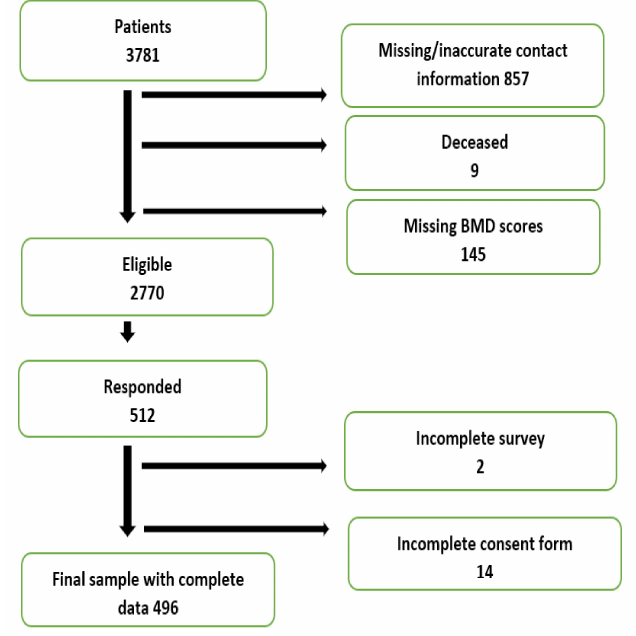
Figure 1. Flow chart of participants’